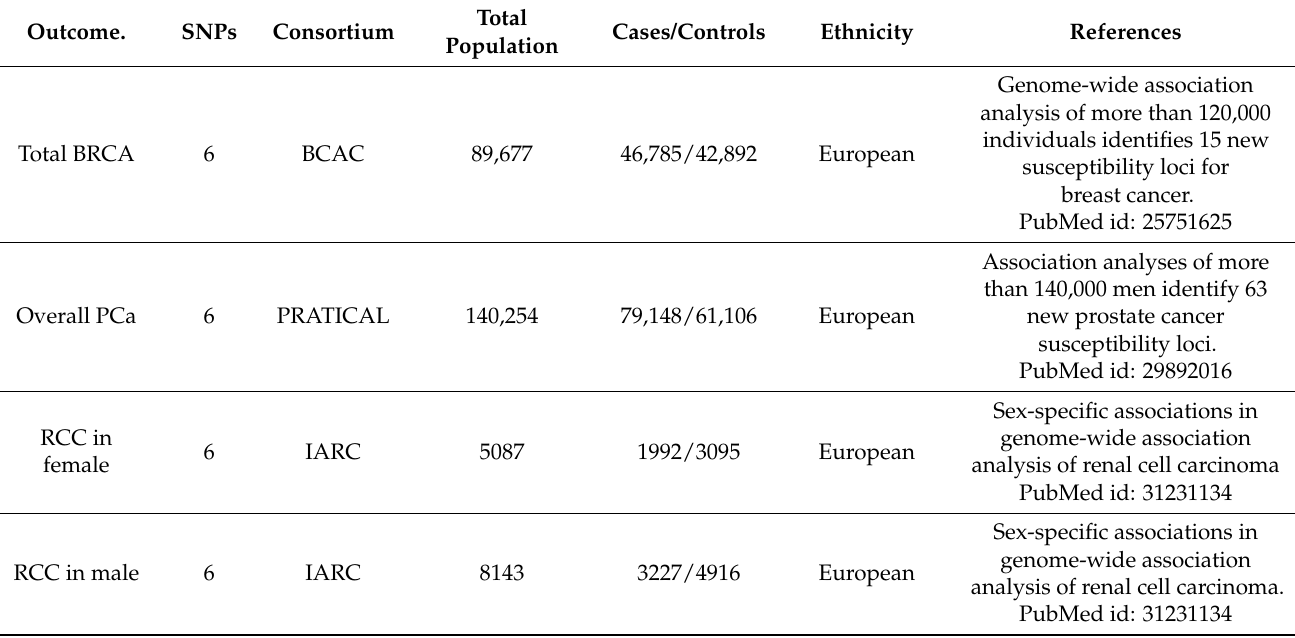
Table 1. The characteristics of GWAS studies on the outcomes.